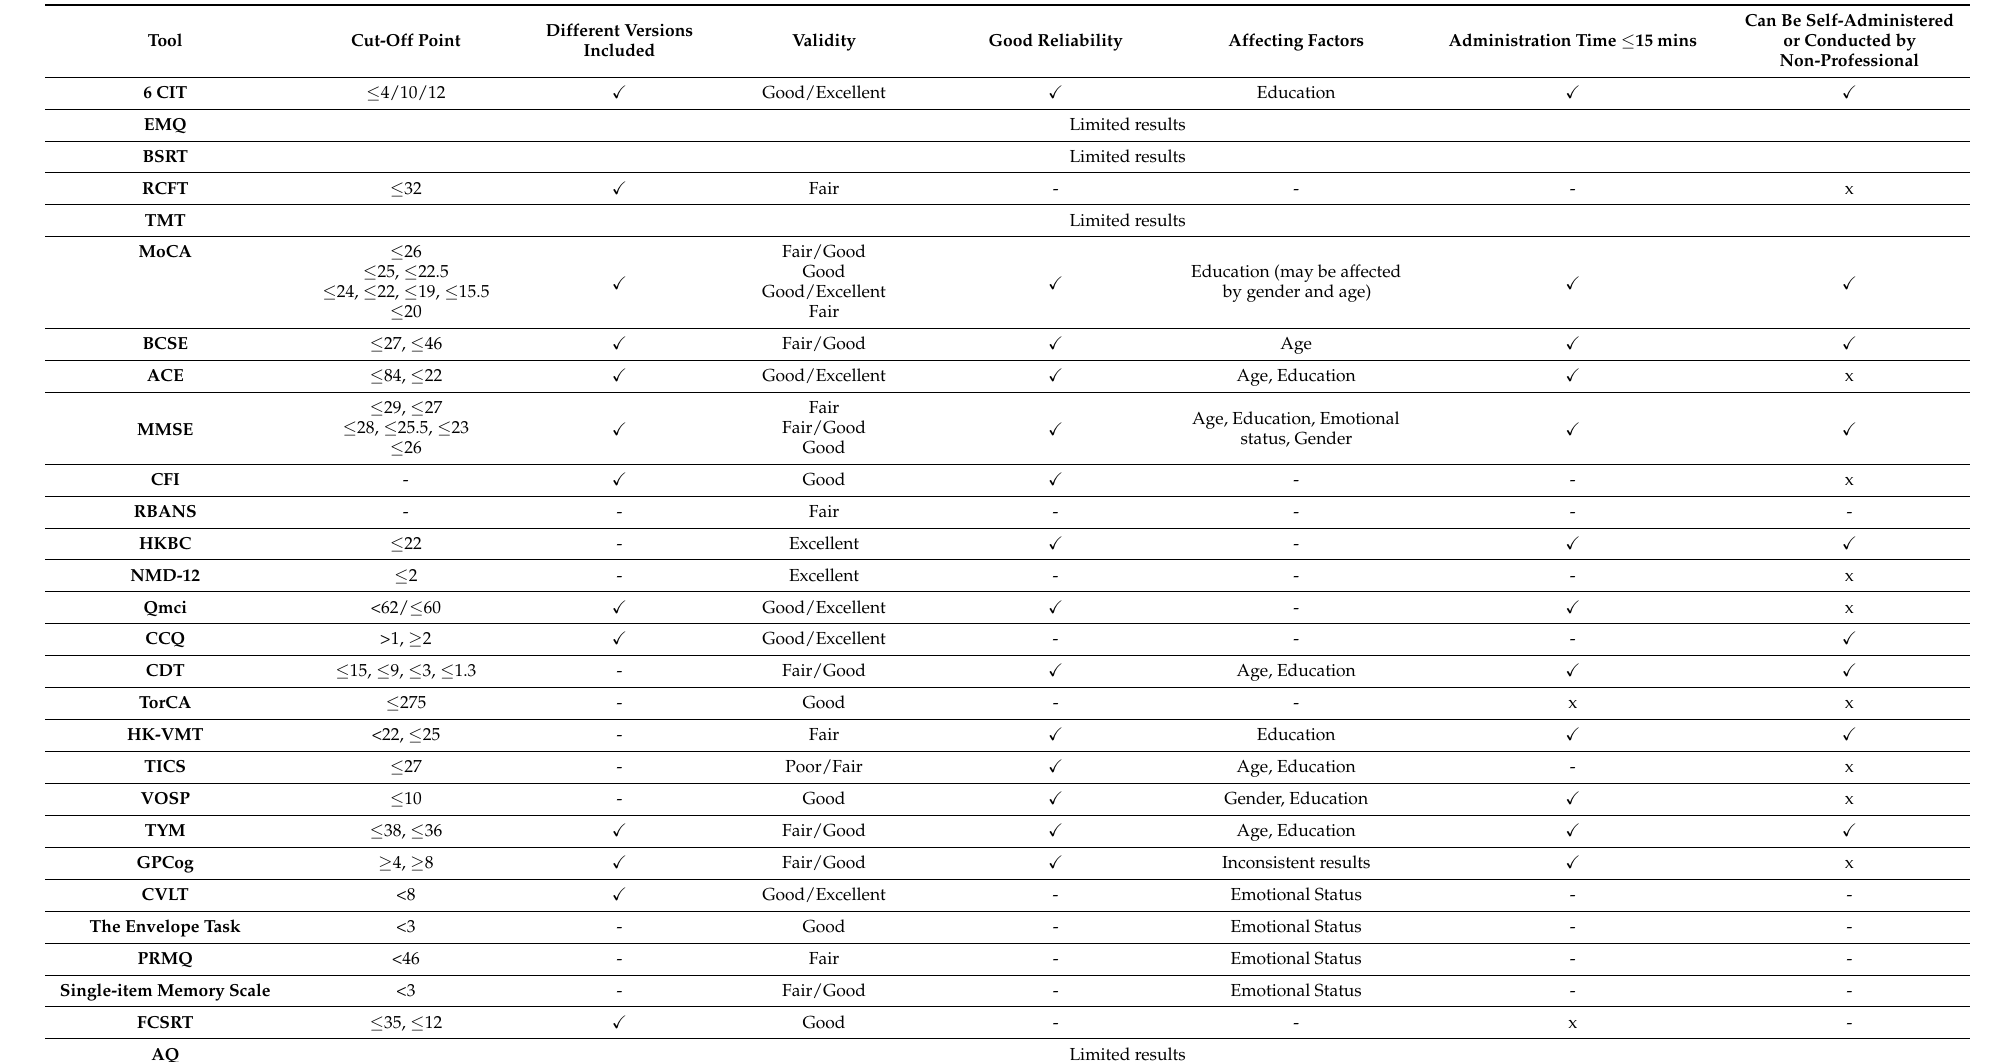
Table 5. Summary of the cognitive tools